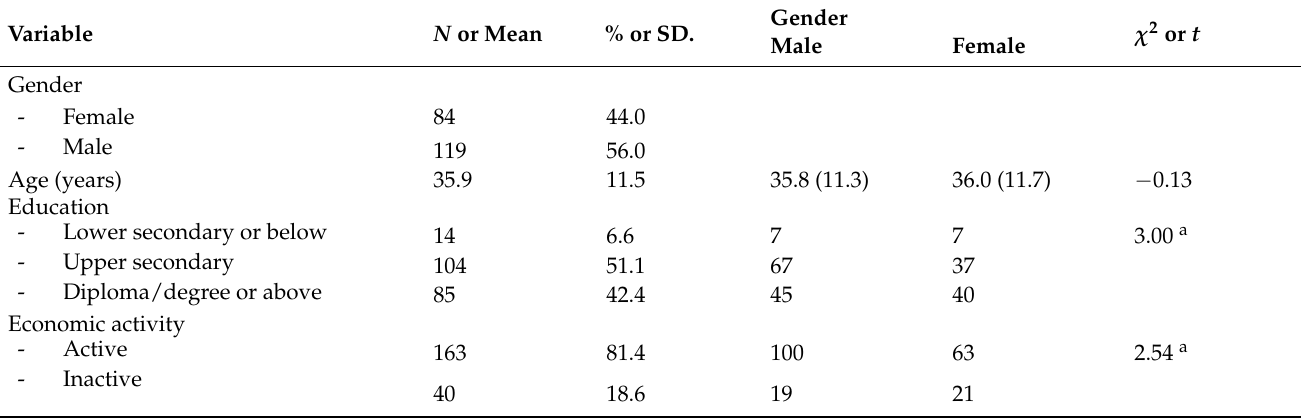
Table 1. Demographic Characteristics of Participants.